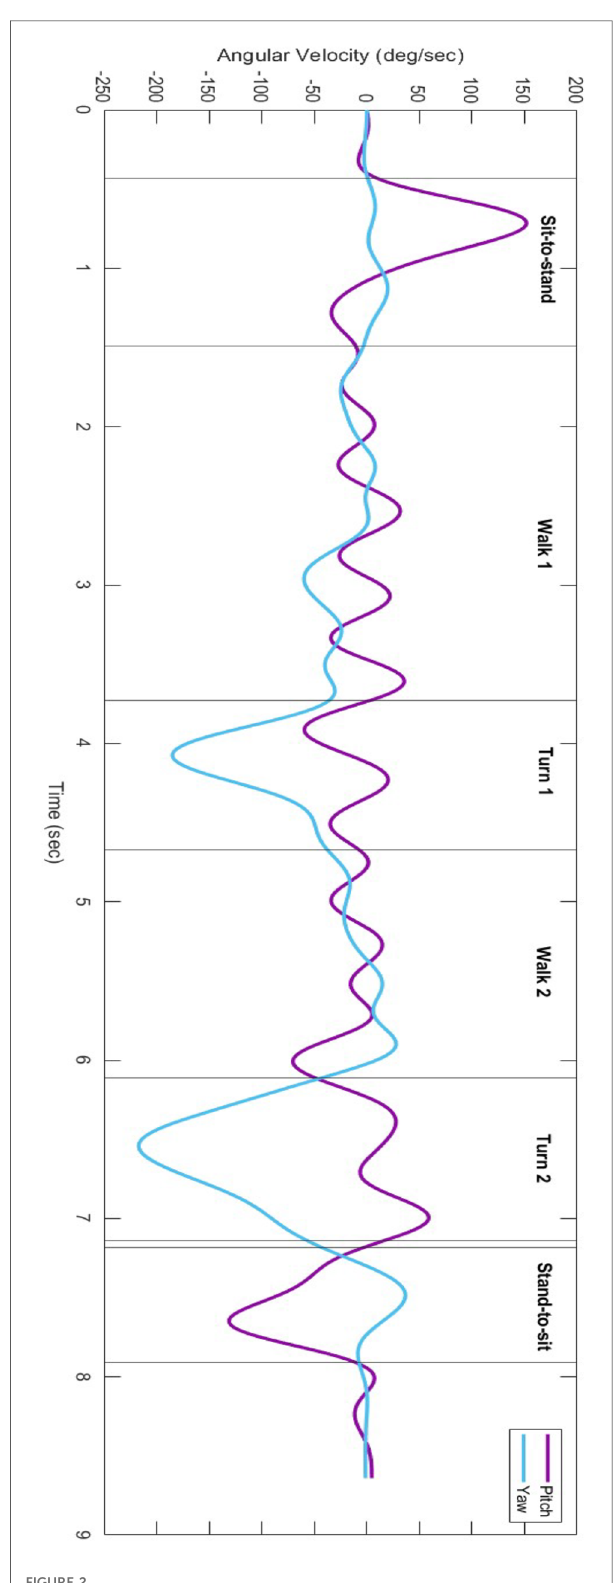
FIGURE 2 An example of a fi ltered signal taken from the lumbar sensor showing the pitch (purple) and yaw (blue) angular velocity signals (deg/sec) from a participant while completing the TUG test.